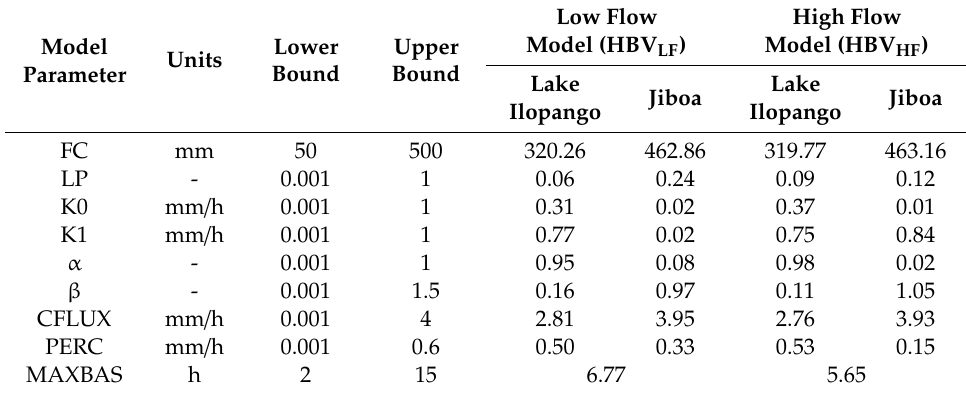
Table 6. Optimal parameters for the two sub-basins and local models HBV HF and HBV LF .